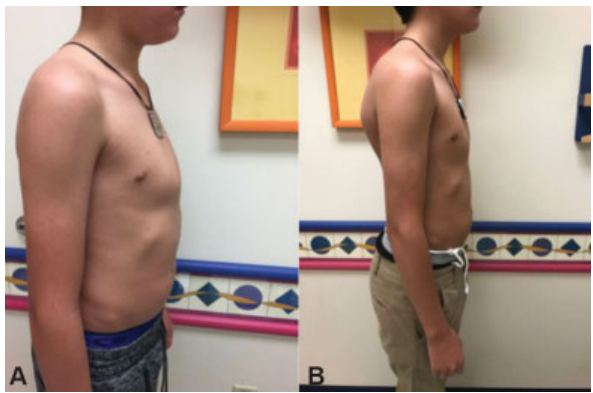
Fig. 2 ( A ) Pectus carinatum before bracing. ( B ) Progression of pectus carinatum after 12 months of